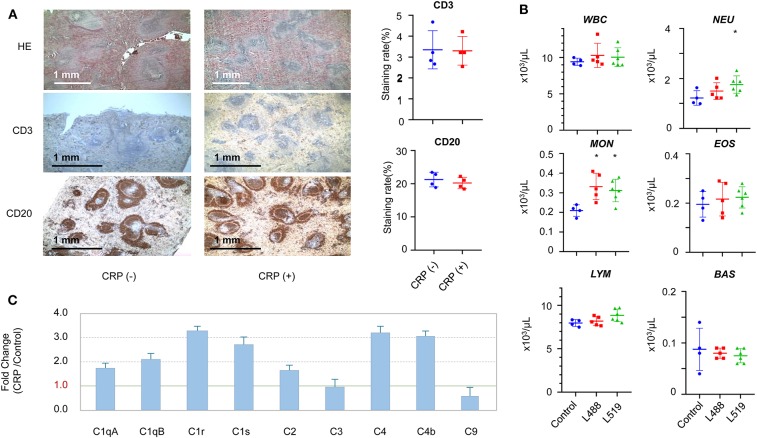
The changes in the immune system induced by chronic CRP elevation. (A) Splenic remodeling. Staining by HE, anti-CD3 (T-cells), and anti-CD20 (B-cells) antibodies (4×), higher density of white pulps was observed in the transgenic rats compared with controls (p = 1.8E-6). Male 26-week-old rats of human CRP transgenic line 519 (n = 2), line 488 (n = 2) and their non-transgenic littermates (n = 4) were included in this experiment. (B) The hematological results of total WBC (white blood cells), neutrophils (NEU), lymphocytes (LYM), monocytes (MON), eosinophils (EOS), basophil (BAS), and absolute large unstained cells (LUC) are shown. Male 26-week-old rats of human CRP transgenic line 519 (n = 6), line 488 (n = 5) and their non-transgenic littermates (n = 4) were included in this experiment (*p < 0.05). (C) The subcomponents of the complement system. Male 16 to 17-week-old rats of human CRP transgenic line 519 (n = 4), line 488 (n = 4) and their non-transgenic littermates (n = 8) were included in this experiment.